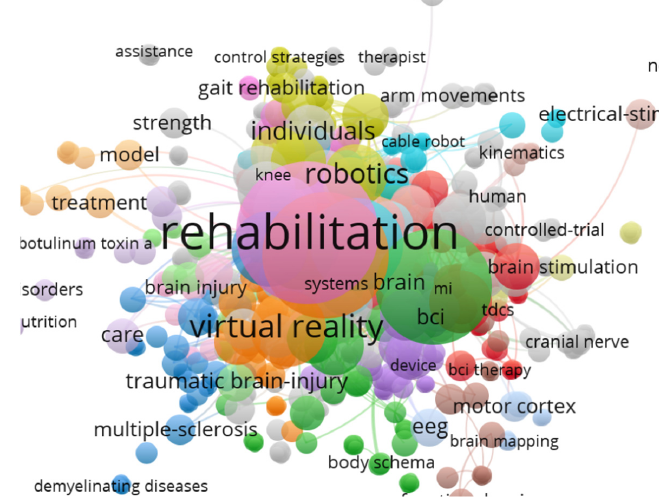
Figure 2. Connection between keywords. Table 2. Top 30 most frequent Table 3. Details of most frequent keywords .